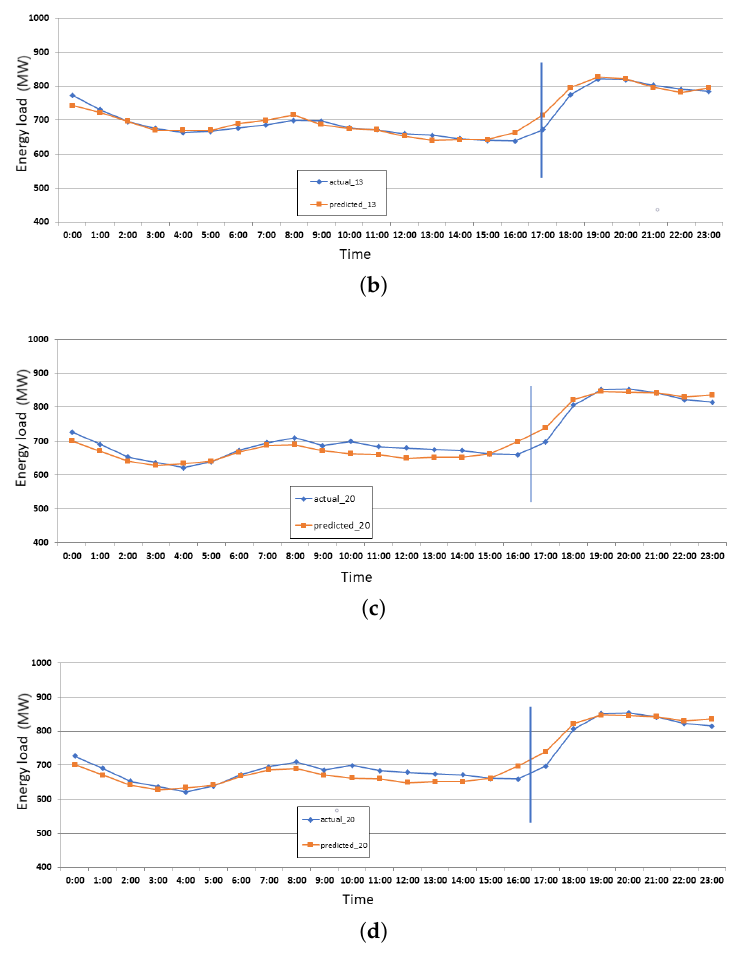
Figure 9. Highest errors recorded in the Sundays of the month of January. ( a ) Sunday, 6 January 2019; ( b ) Sunday, 13 January 2019; ( c ) Sunday, 20 January 2019; ( d ) Sunday, 27 January 2019.